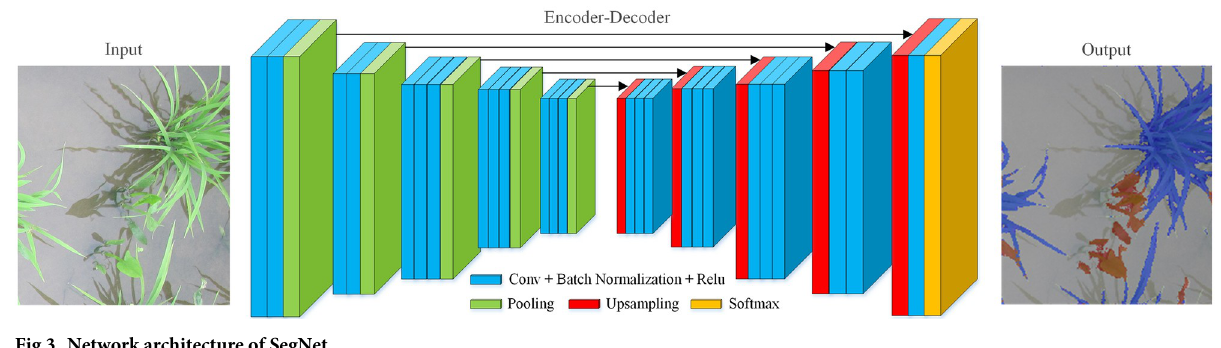
Fig 3. Network architecture of